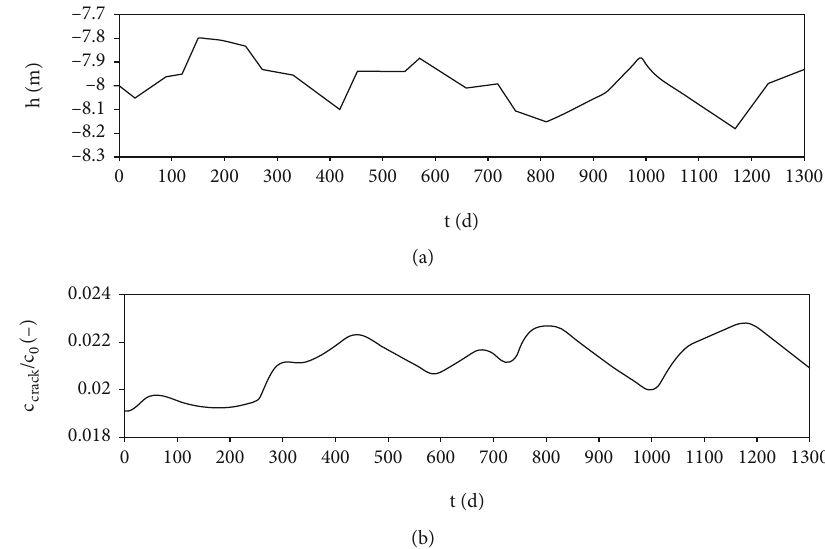
Figure 11: The groundwater table elevation data in the second site (Holton et al., [28] and Guo et al. [27]) and simulated normalized TCE concentrations at the